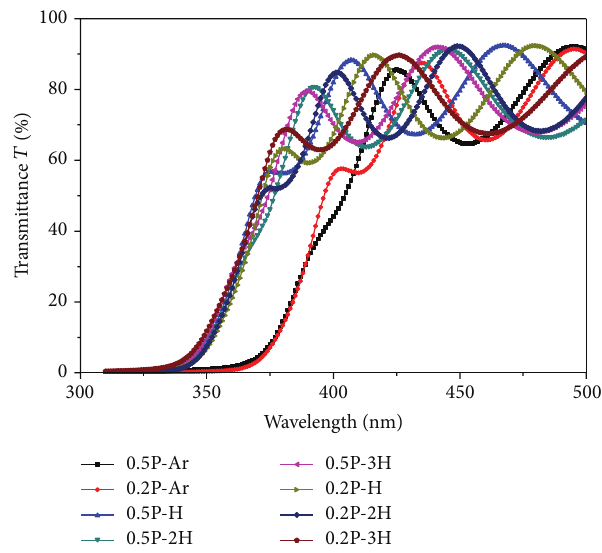
Figure 7: Transmittance versus wavelength spectra of ZnS films grown at various sputtering pressures.